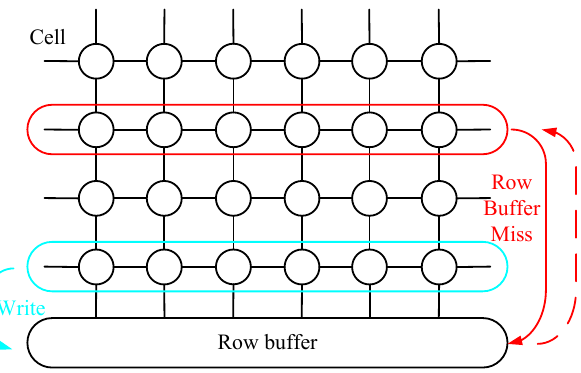
Figure 2. Row buffer architecture with an open page strategy.